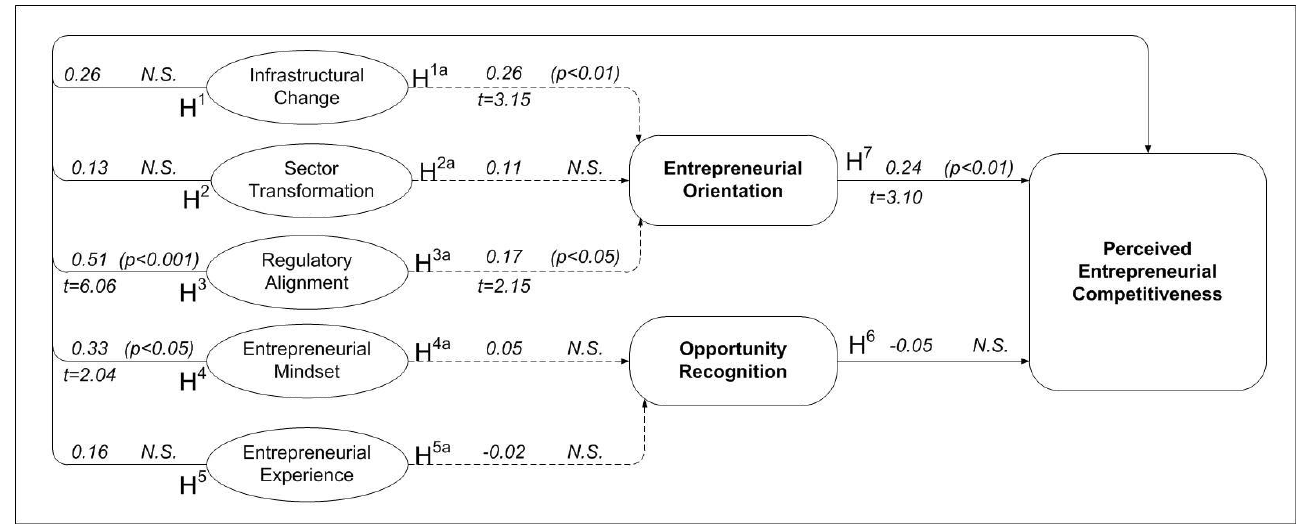
Figure 1: Hypothesised relationships and structural model